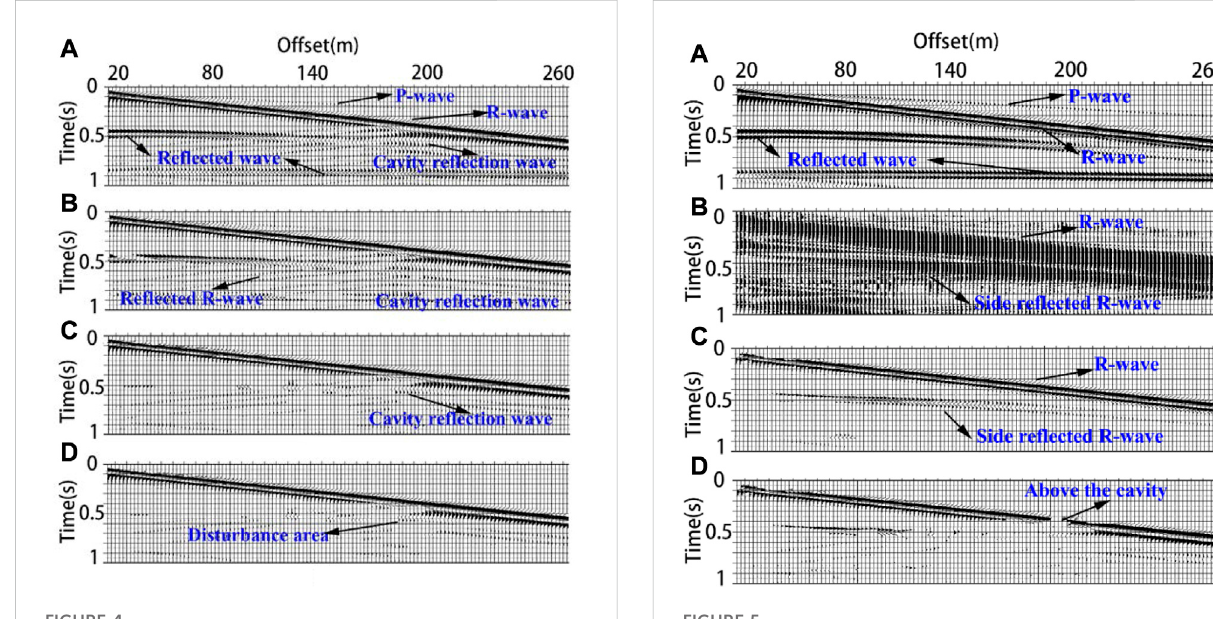
S-wave re fl ected from the bottom edge in Figure 3B was fi ltered, and